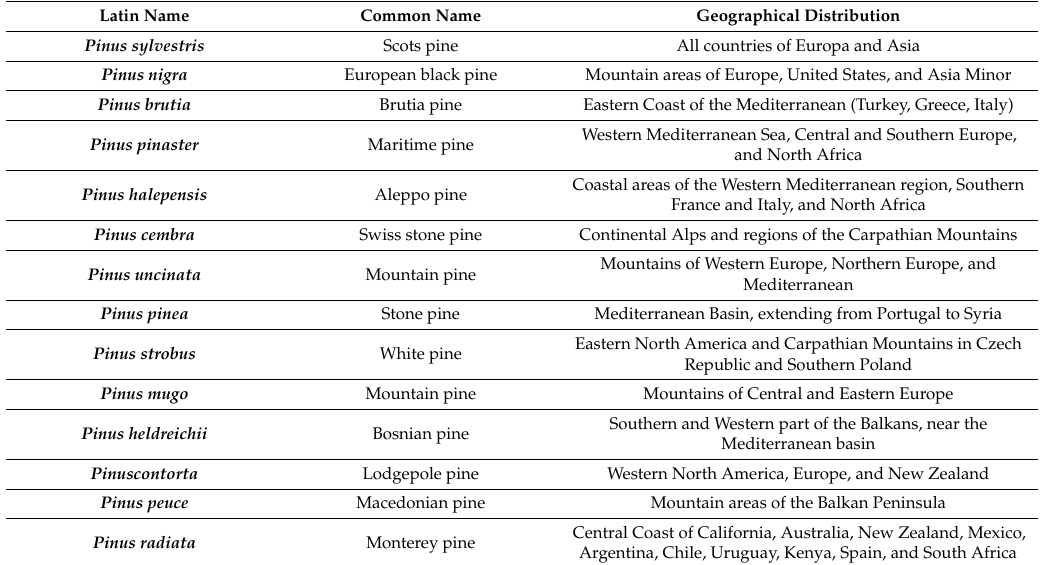
Table 1. Pinus trees species implemented in European countries, as well as its geographical